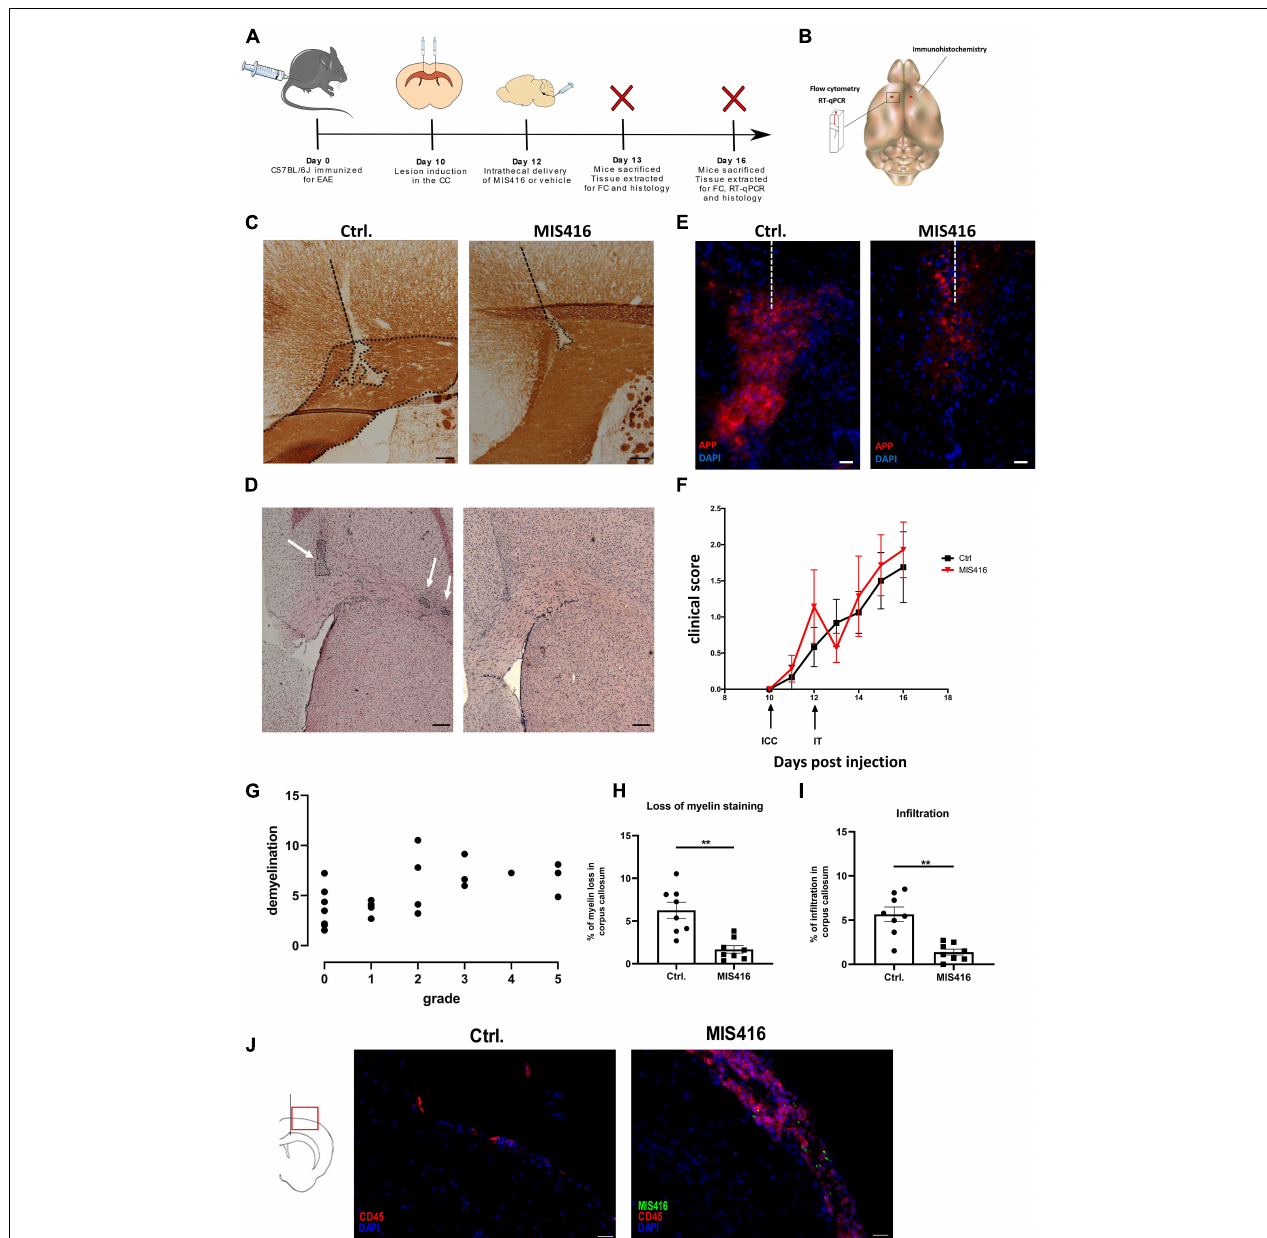
FIGURE 1 | Intrathecal MIS416 reduced focal lesion pathology and altered inflammatory responses at the lesion site. (A) Experimental layout: C57BL/6J mice were immunized for EAE (day 0) and a focal lesion in CC was induced by a stereotactic needle insertion (day 10). Mice then received intrathecal injection with either MIS416 or vehicle (day 12). Animals were sacrificed and tissue extracted for analysis by immunohistochemistry, RT-qPCR or FC (day 13 and 16). (B) A Schematic illustration demonstrating the selected fragment of brain tissue surrounding the lesion site (approx. 50 mg) which was isolated for RT-qPCR and FC. The red dots indicate the injection sites. The whole right hemisphere was isolated for immunohistochemical evaluation. (C) Representative images of CC from vehicle (Ctrl, left panel) and MIS416-treated (right panel) groups stained with anti-MOG. Demyelination was identified by loss of MOG staining. Dotted lines represent the needle track and the area of demyelination. Scale bars: 100 µ m (D) Representative images of CC from vehicle (Ctrl, left panel) and MIS416-treated (right panel) groups stained with H+E to show infiltration. Scale bars: 200 µ m. (E) Immunofluorescence staining of brain section (day 16) with anti-APP (red) and nuclear staining (DAPI, blue) from mice intrathecally injected with vehicle (Ctrl) or MIS416. Scale bar: 20 µ m. (F) Clinical scores of mice with focal EAE. Shown is pooled data from two individual experiments. MIS416 treated mice (red symbols, n = 8) and control mice (black symbols, n = 8). (G) Correlation between EAE grade and lesion size. The graph shows pooled data from mice with focal EAE (but otherwise untreated), from 4 different experiments ( n = 22, r = 0.632, p = 0.0012). (H) Quantification of demyelination, calculated as a percentage of CC in vehicle (Ctrl, n = 8) and MIS416 ( n = 8) treated groups. (I) Quantification of infiltration in the CC in vehicle (Ctrl, n = 8) and MIS416 ( n = 8) treated groups. Data are presented as mean ± SEM. Results were analyzed using the two-tailed Mann-Whitney u -test; ** p < 0.01. (J) Immunofluorescence staining of brain section (day 16) with anti-CD45 (red) and nuclear staining (DAPI, blue) from mice intrathecally injected with vehicle (Ctrl) or fluorescent MIS416 (green). Scale bar: 20 µ